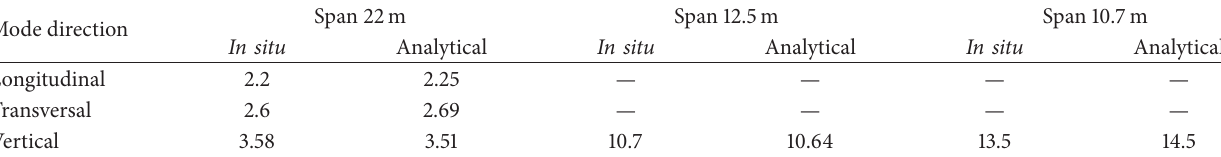
Table 11: Comparison of frequencies (Hz) between measurements in situ and the analytical model. Span 22 m Span 12.5 m Span 10.7 m Mode direction In situ Analytical In situ Analytical In situ Analytical Longitudinal 2.2 2.25 — — — — Transversal 2.6 2.69 — — — — Vertical